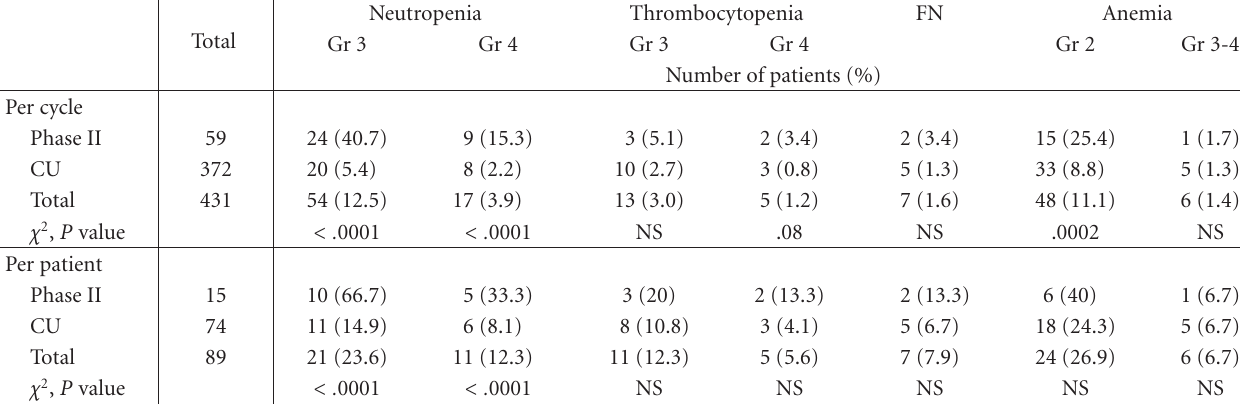
Table 5: Hematologic toxicities (NCI-CTC grade) per cycle and per patient. NCI-CTC: National Cancer Institute Common Toxicity Criteria; Gr: grade; FN: febrile neutropenia; NS: not significant.